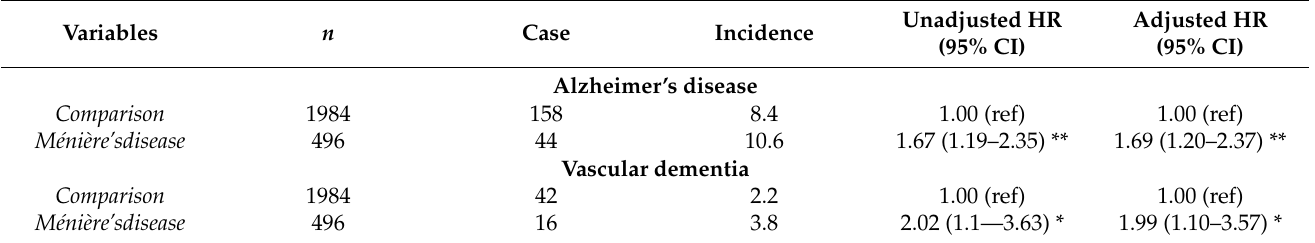
Table 5. Incidence per 1000 person–years and HR (95% CI) of specific diseases (Alzheimer’s disease and vascular